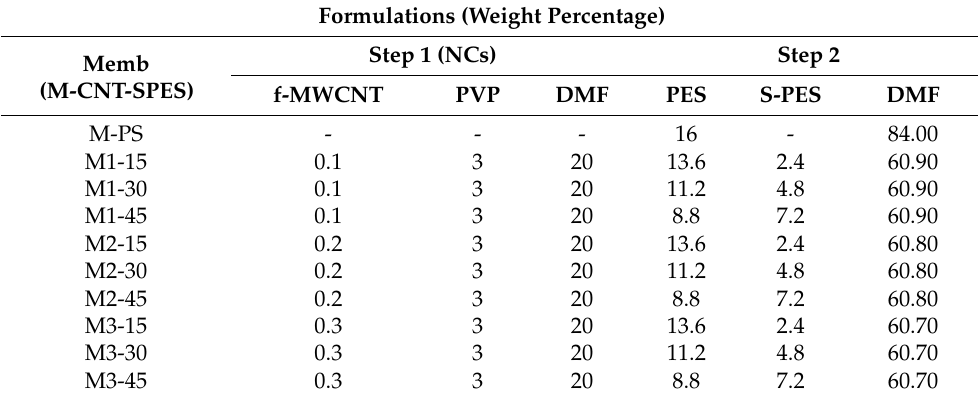
Table 1. Formulation of SPES and nanocomposite based membranes. Formulations (Weight